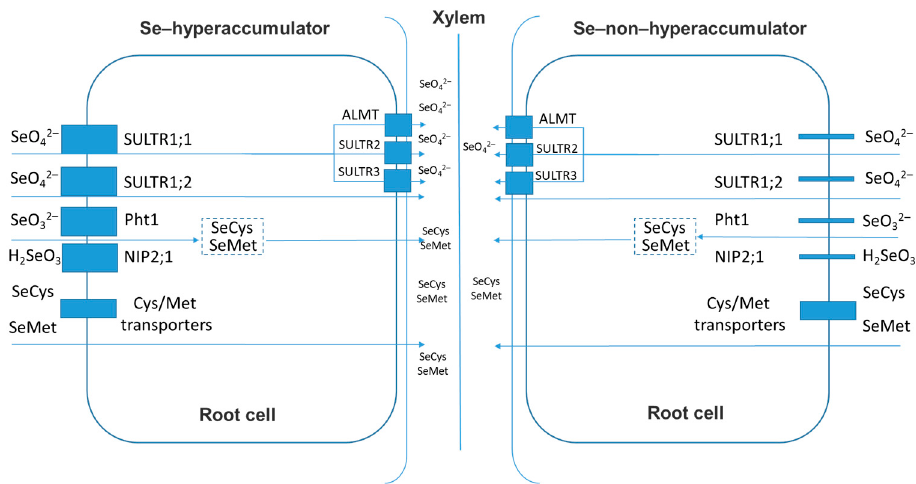
Figure 1. Pathways of Se uptake by plants classified as Se-hyperaccumulator and Se-non-hyperac- cumulator.